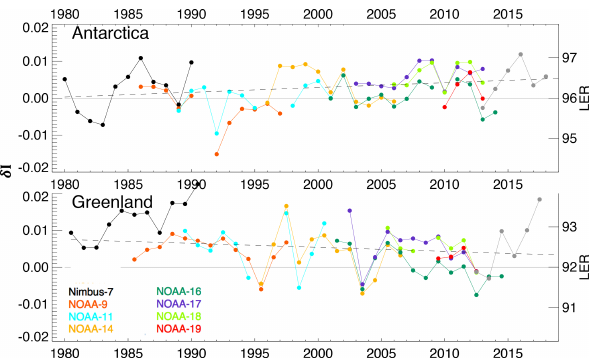
Figure 2. Inter-annual variability of previously calibrated δI for the SBUV instruments (colored) and OMPS Mapper (grey) over Antarctica and Greenland. The right-hand axis shows the corre- sponding change in LER.